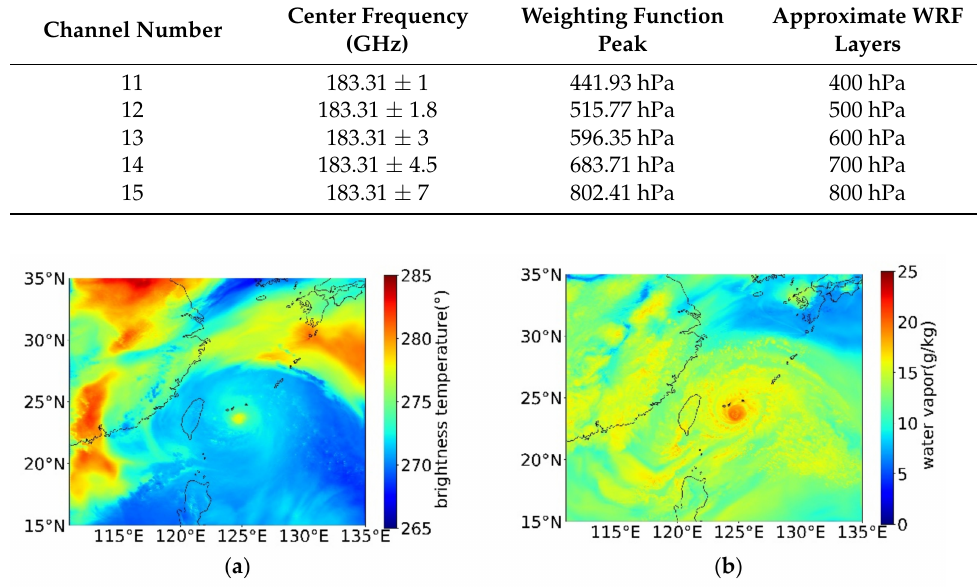
Figure 3. The BT ( a ) of 183.31 ± 7 GHz and the water vapor ( b ) of 800